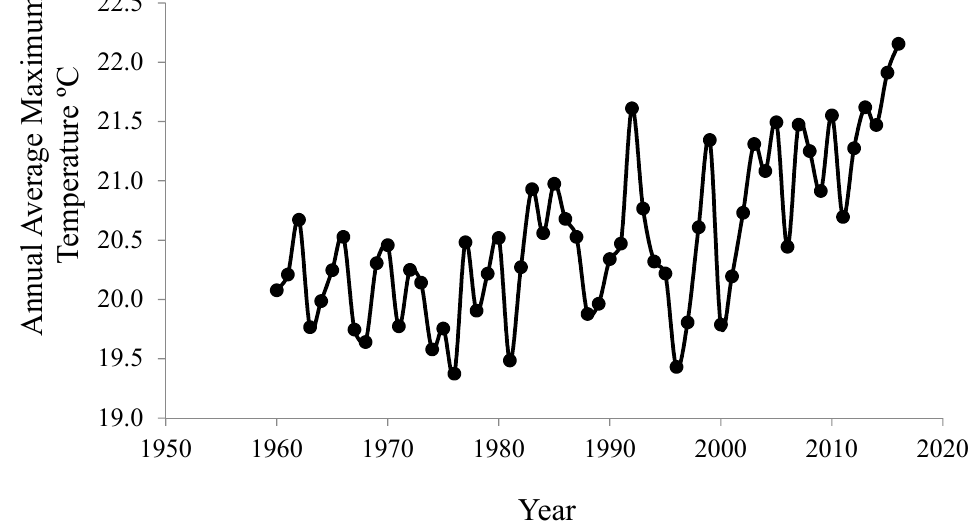
Figure 2. Annual average maximum temperature for the period 1960–2016.